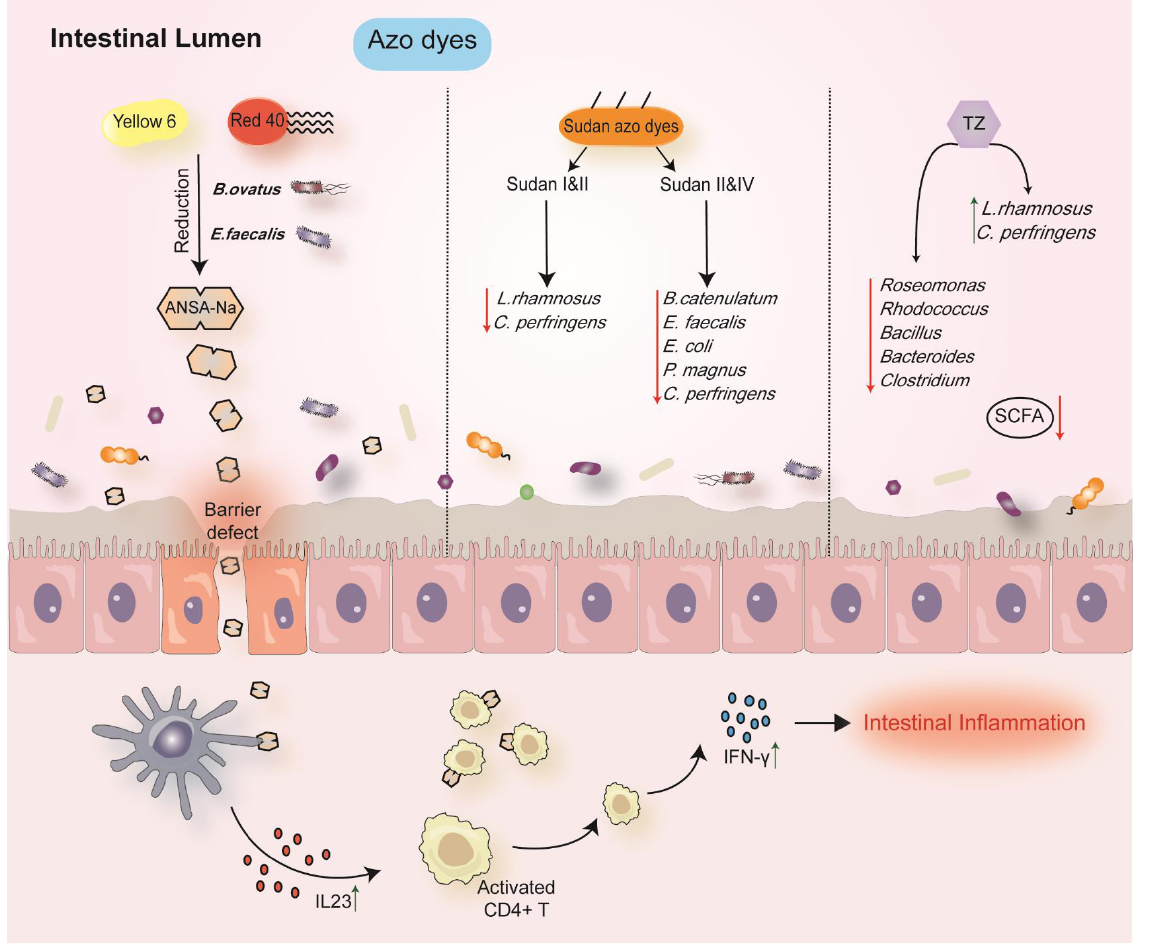
Figure 3. The influence of different food colorants on mucosal barrier and intestinal microecology. “ ↑ ” means an increased level; “ ↓ ” means a decreased level.